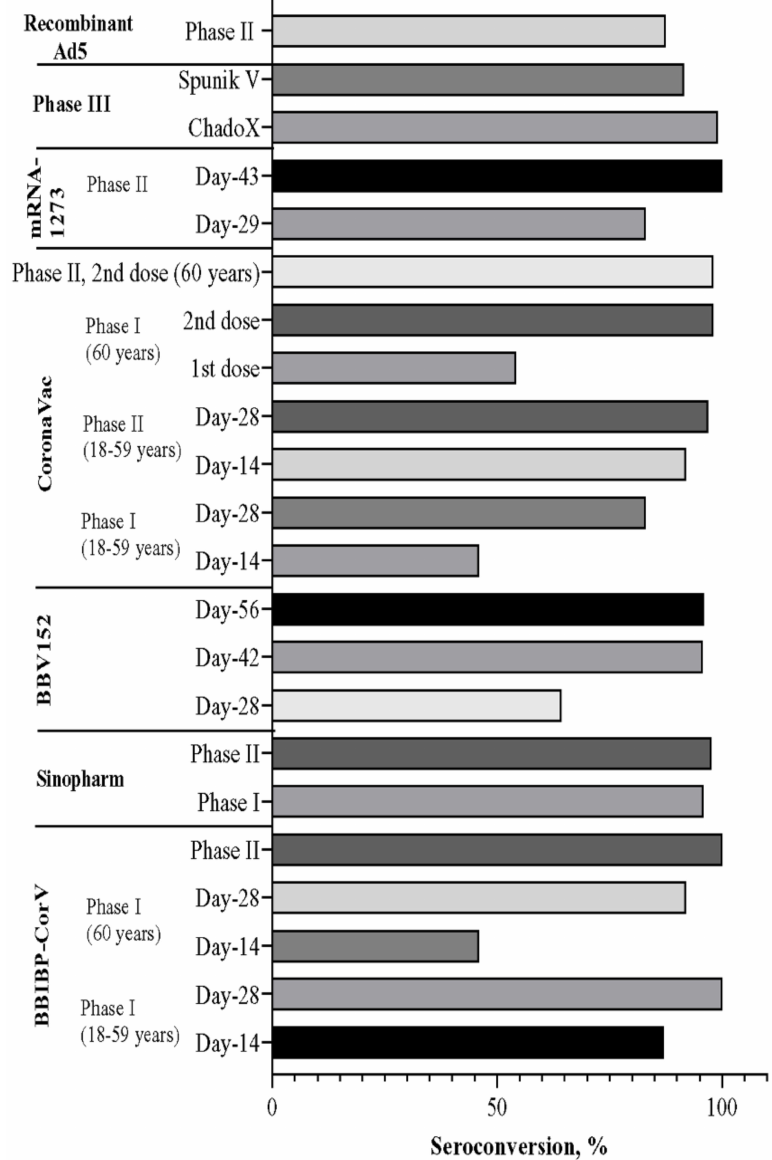
Figure 4. IgG seroconversion of several SARS-CoV-2 vaccines by trial Phase (i.e., Phase I/II/III), dose number (i.e., 1st or 2nd dose), or days after vaccination (i.e., day 14/28/29/42/56). Data were extracted from the included articles which were selected for this systematic review